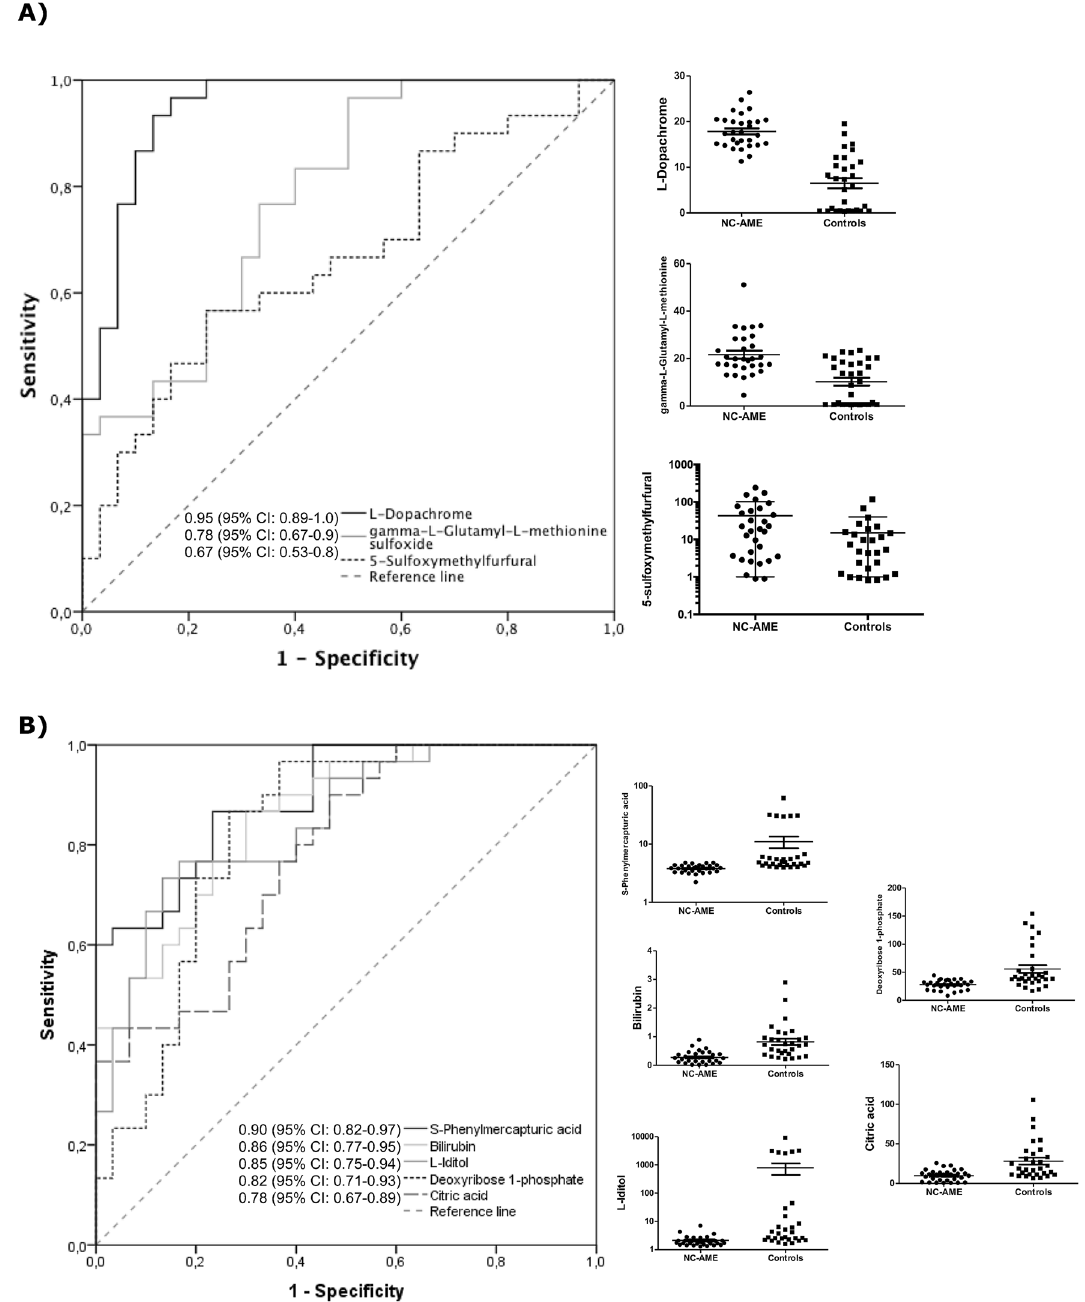
metabolites; ( B ) Downregulated